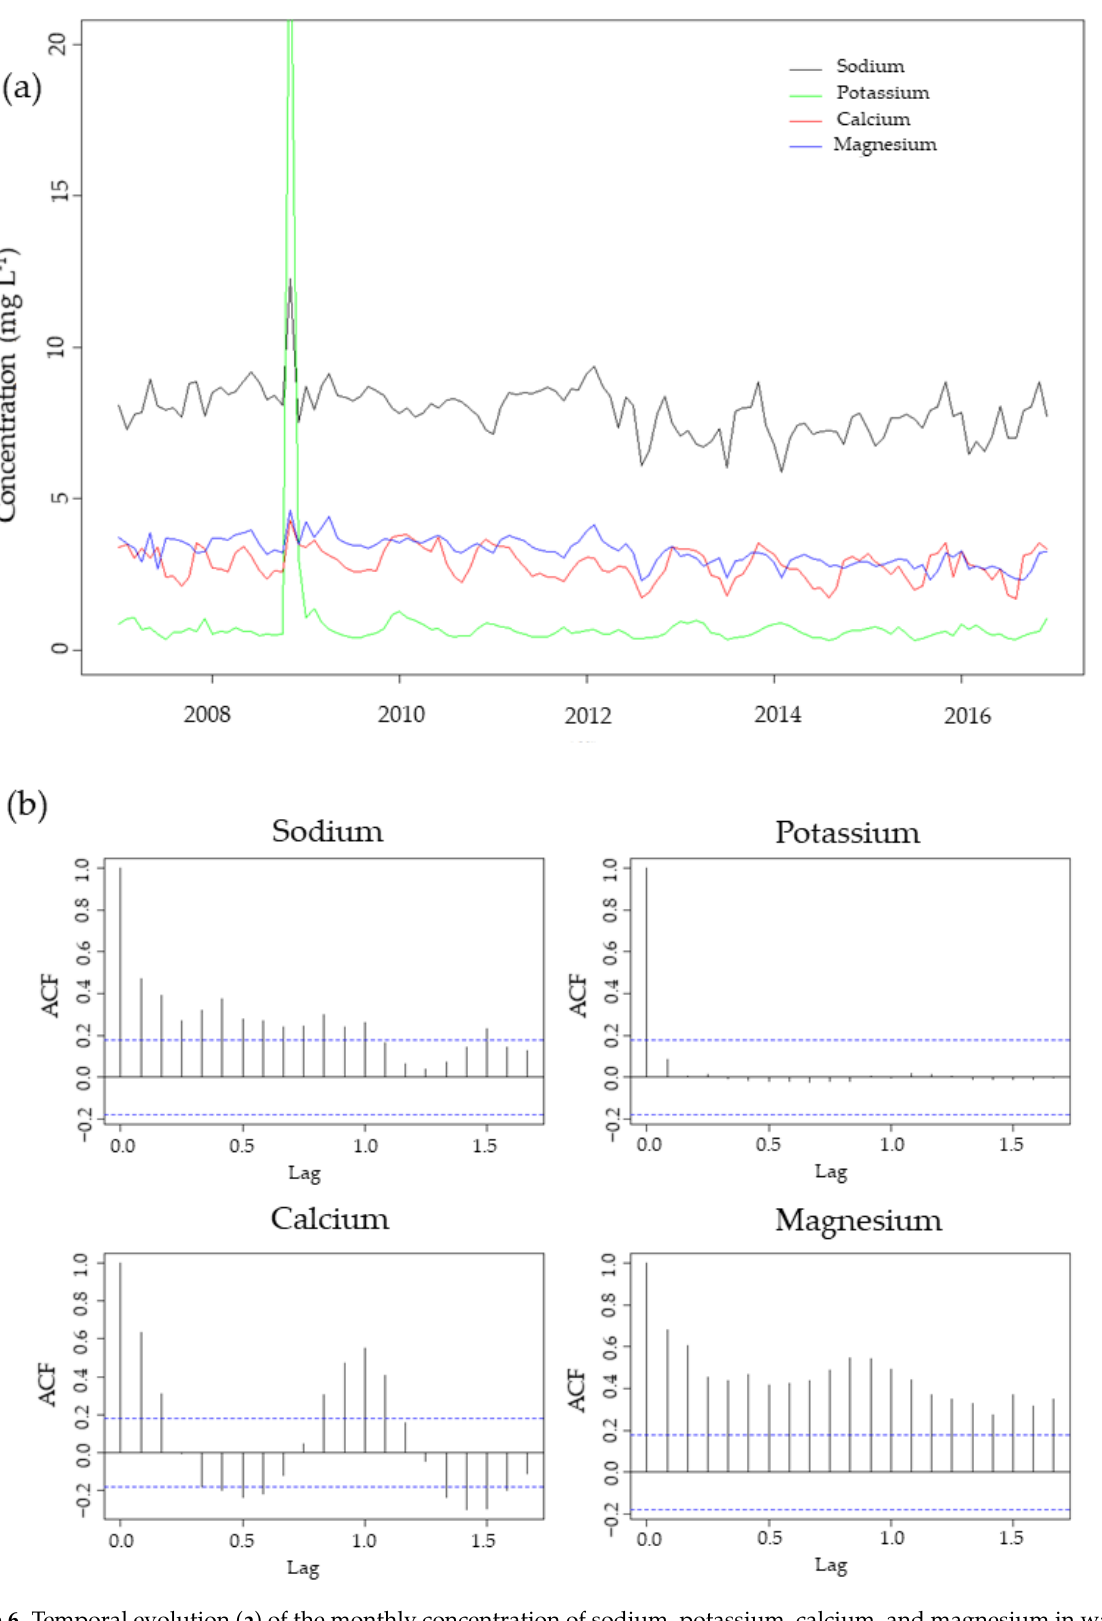
Figure 6. Temporal evolution ( a ) of the monthly concentration of sodium, potassium, calcium, and magnesium in water samples of the Abelar catchment. Autocorrelation functions (ACF) for the four studied macronutrients ( b ).